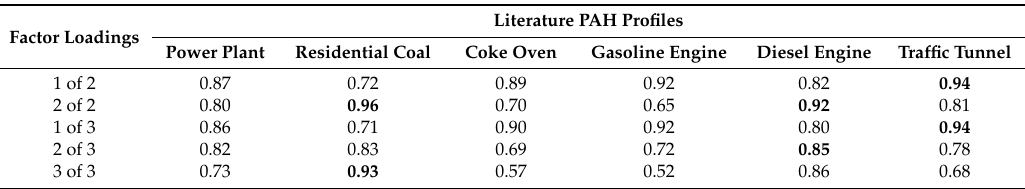
Table 2. Cosine similarity of modeled and literature source profiles [4,19]. Literature PAH Factor Loadings